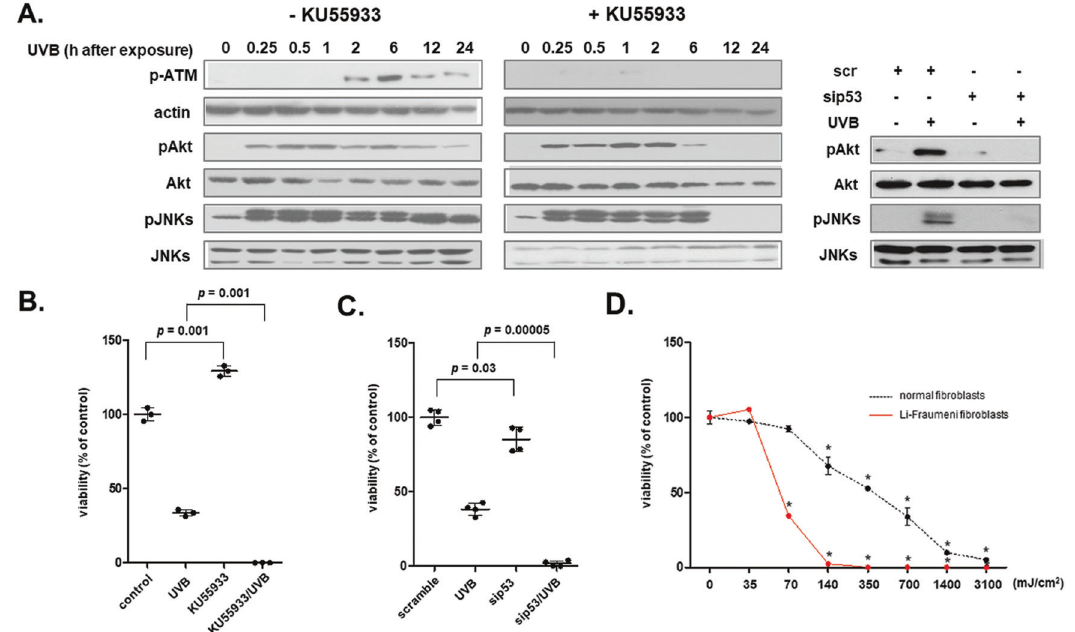
Fig. 7 A functional DNA damage response is indispensable for the activation of human dermal fi broblasts ’ defensive mechanisms towards UVB-induced cytotoxicity. A Cells were pre-incubated with 5 μ M of the speci fi c ATM inhibitor KU55933 for 1 h, exposed to 700 mJ/ cm 2 of UVB radiation and further incubated at 37 o C for the designated time periods before total protein extraction and western blot analysis using antibodies against phospho-ATM at Ser1981, phospho-Akt at Ser473 and phospho-JNKs. Additionally, cells were transfected with 50 nM of either a predesigned scramble or the human p53 siRNA sequence before their exposure to 700 mJ/cm 2 of UVB radiation, protein extraction 12 h post-irradiation and western blot analysis for phospho-Akt at Ser473 and phospho-JNKs. The non-phosphorylated forms of Akt and JNKs, as well as actin were analyzed in order to verify equal loading. Representative blots of three independent experiments are shown. Cells were pre-incubated with 5 μ M of the speci fi c ATM inhibitor KU55933 for 1 h ( B ) or transfected with 50 nM of either scramble or p53 siRNA ( C ), exposed to 700 mJ/cm 2 of UVB radiation and further incubated at 37 o C for 72 h before staining with Neutral Red and cell counting. Graphs are representative of three independent experiments and p for statistically signi fi cant differences in comparison to the respective sample without the inhibitor ( B ) or to the respective scramble ( C ) is presented. D MDAH041 fi broblasts from a Li-Fraumeni patient were irradiated with UVB irradiation doses ranging from 35 to 3100 mJ/cm 2 . After incubation at 37 o C for 72 h, cells were detached by trypsinization, stained with Neutral Red, and measured using a haemocytometer. Untreated cells served as the reference sample for the estimation of cell viability. A representative graph out of three similar ones from independent experiments is shown here. Asterisks denote statistically signi fi